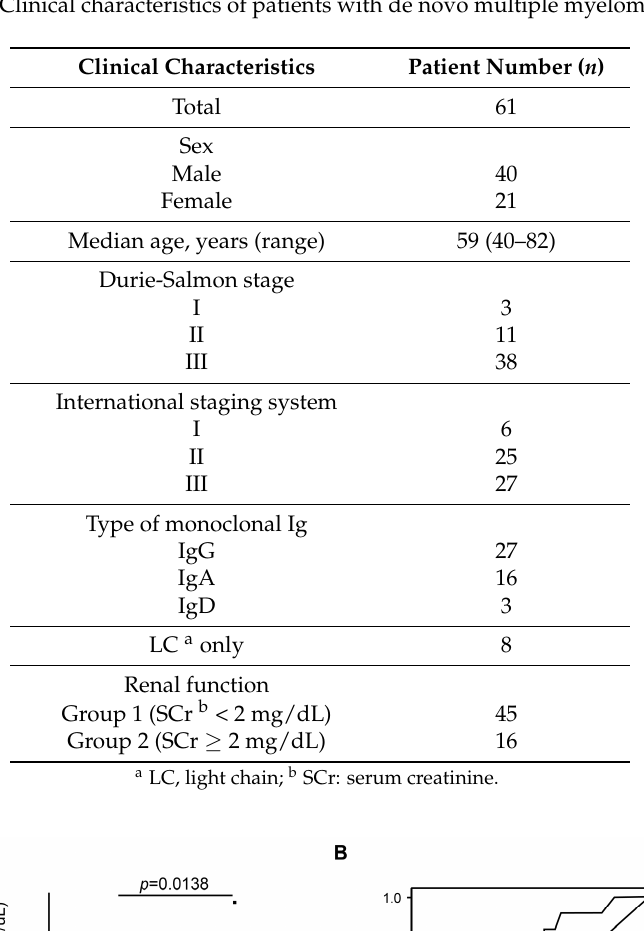
Table 1. Clinical characteristics of patients with de novo multiple myeloma (MM).